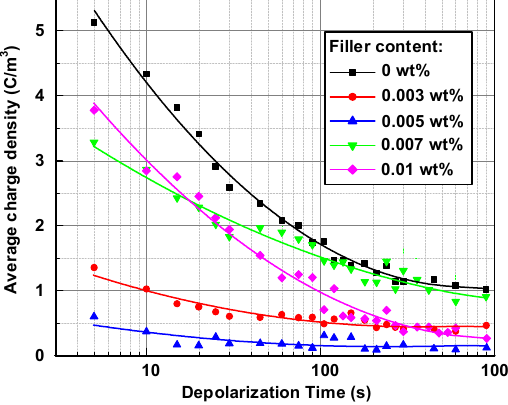
Figure 7. Relationship between the average charge density and depolarization time of graphene/LDPE composites at the shorted-circuit condition at 60 °C.